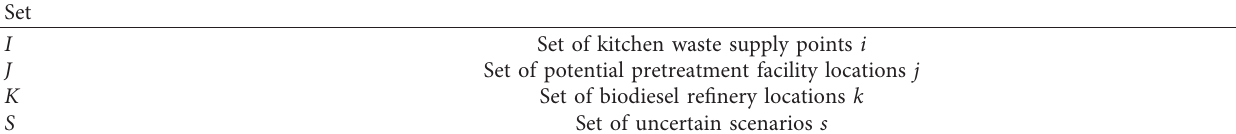
Table 1: Description of symbols used in the base